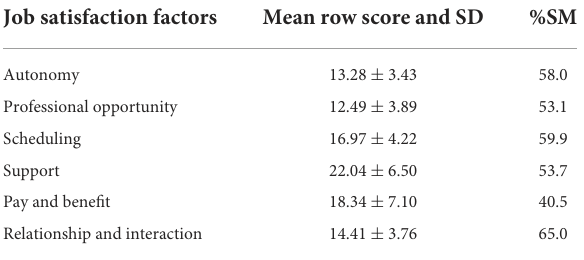
TABLE 2 Job satisfaction items with respective mean and percentage scores of health professionals working in public primary health facilities of Addis Ababa, Ethiopia,